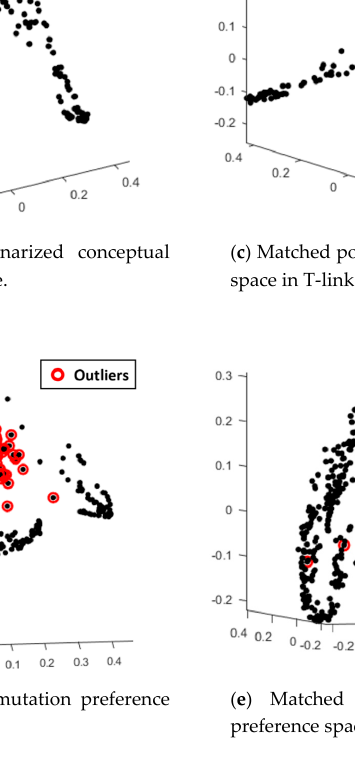
Figure 3. The distribution of matched points for homography estimation in different preference spaces.